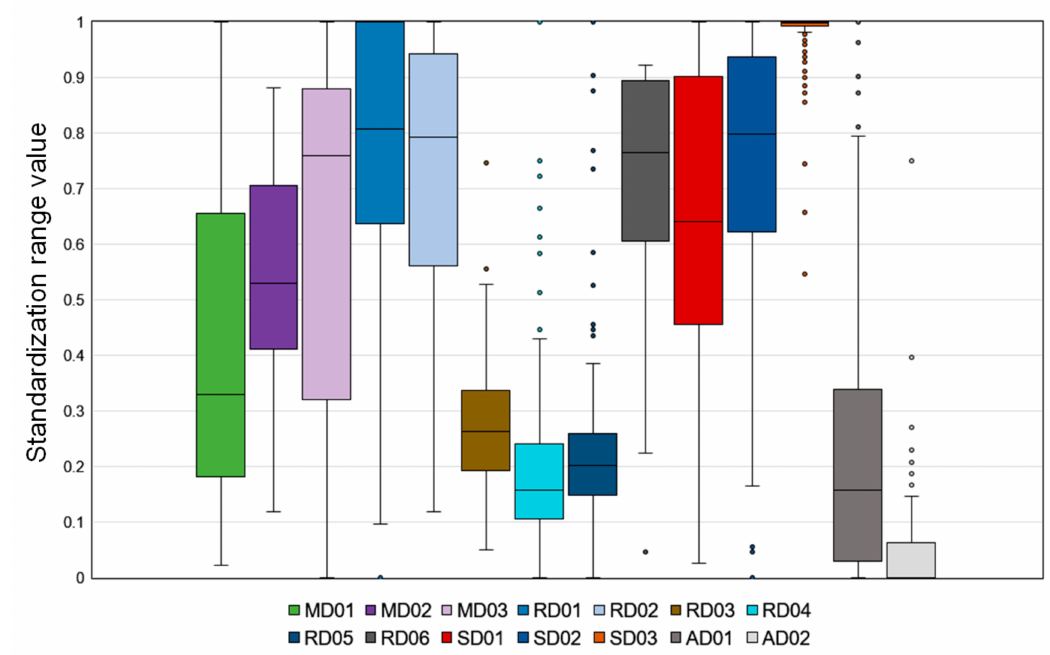
Figure 3. Standardization range for each indicator (MD: meteorological data, RD: agricultural reservoir data, SD: social data, AD: adaptability